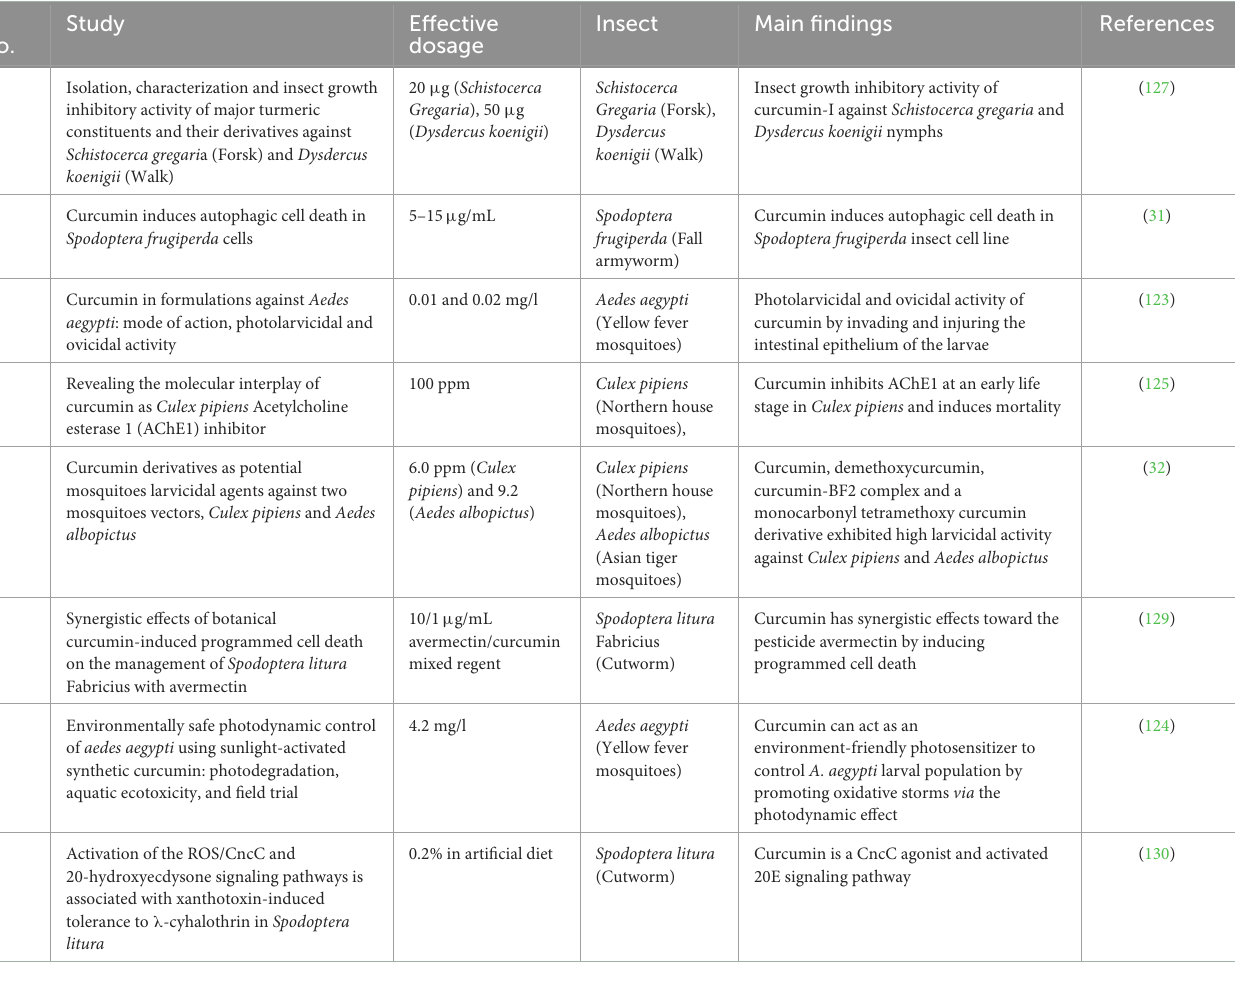
TABLE 4 Evaluation of curcumin’s beneficial effects in the model insects and organisms. S.